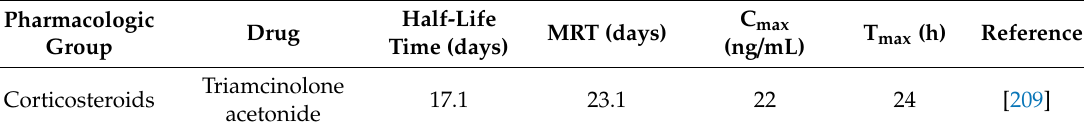
Table 7. Vitreous pharmacokinetic parameters for long-acting triamcinolone acetonide subTenon’s